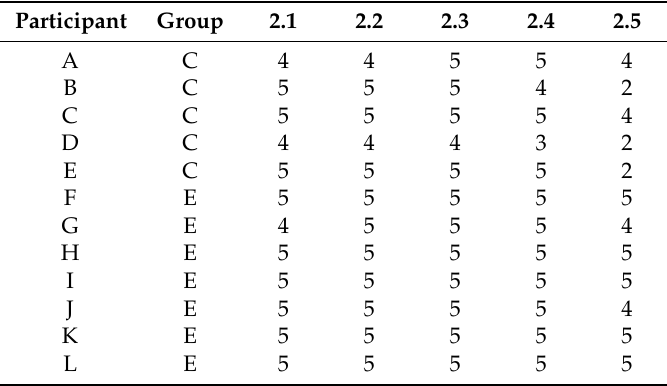
Table A9. Interim-survey section results 2/3.